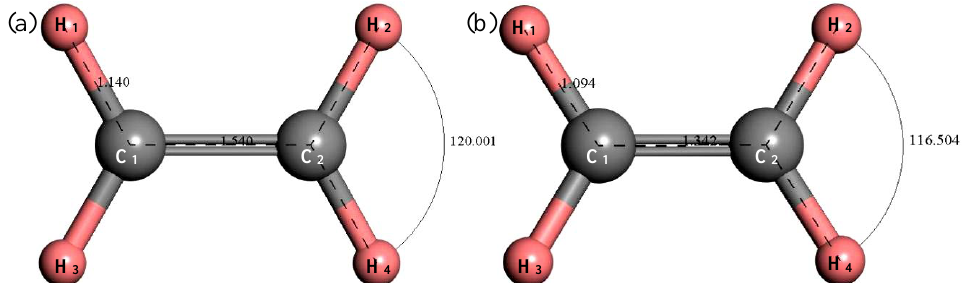
Figure 12. Molecular model of C 2 H 4 molecule. ( a ) Initial model; ( b ) Optimized model. The unit of the angle in the image is (°), and the unit of the bond length is angstrom (Å). Materials 2019 , 12 , 330